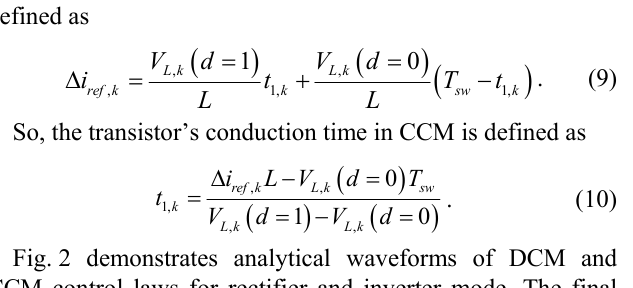
CCM control laws for rectifier and inverter mode. The final commutation signal is selected as minimum value of DCM and CCM